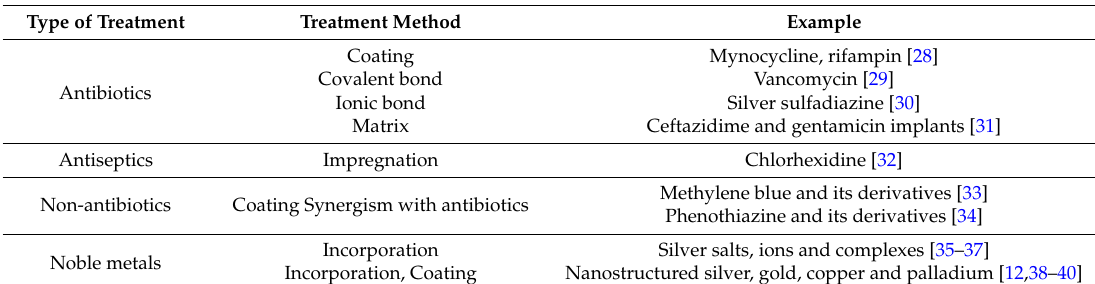
Figure 3. Effects of antimicrobial treatment of polymeric medical devices: ( A ) prevention of bacterial adhesion; ( B ) inhibition of bacterial colonization (preclusion of biofilm formation).